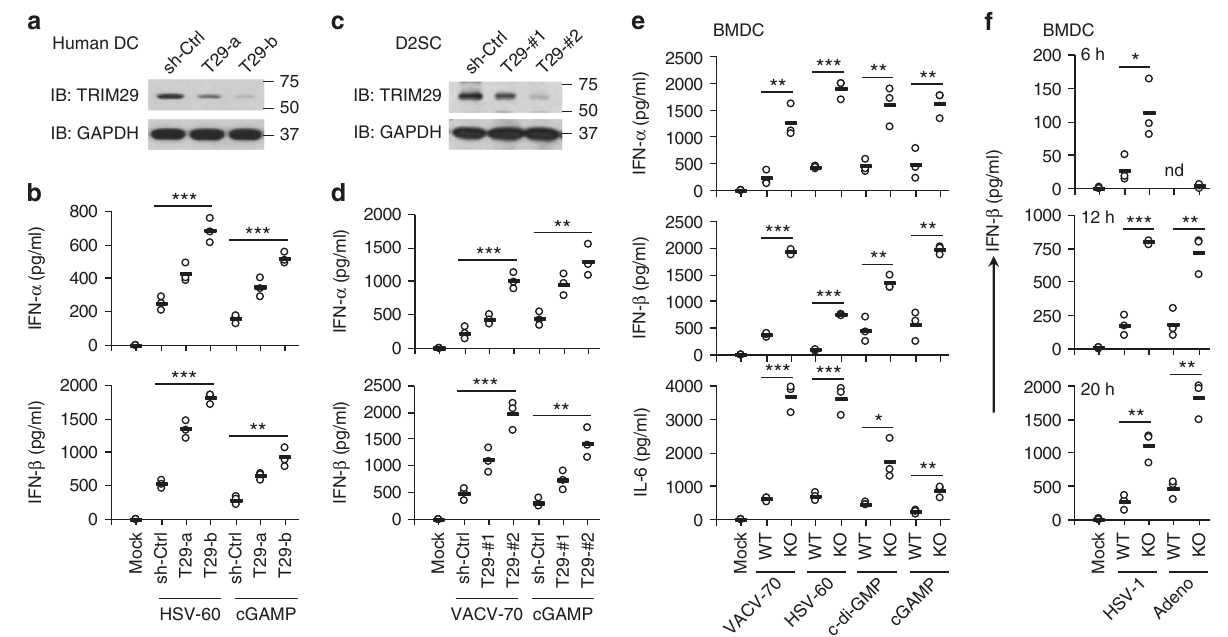
Fig. 3 TRIM29 plays an important role in regulating IFN-I production in dendritic cells. a Immunoblot analysis of TRIM29 in human monocyte-derived dendritic cells (MonoDC) treated with control shRNA with scrambled sequence (sh-Ctrl), shRNA targeting mRNA encoding TRIM29 (two shRNAs: T29-a and T29-b). GAPDH serves as a loading control throughout. b ELISA of IFN- α and IFN- β in MonoDCs treated with scrambled shRNA (sh-Ctrl) and left unstimulated (Mock) or treated with shRNA as above and then stimulated for 16 h with dsDNA derived from herpes simplex virus type 1 (HSV-60, 2.5 μ g/ml) or cGAMP (1.0 μ g/ml) delivered by Lipofectamine 3000. c Immunoblot analysis of TRIM29 in mouse D2SC cells treated with control shRNA with scrambled sequence (sh-Ctrl), shRNA targeting mRNA encoding TRIM29 (two shRNAs: T29-#1 and T29-#2). GAPDH serves as a loading control throughout. d ELISA of IFN- α and IFN- β in D2SC cells treated with scrambled shRNA (sh-Ctrl) and left unstimulated (Mock) or treated with shRNA as above and then stimulated for 16 h with dsDNA from vaccinia virus (VACV-70, 2.5 μ g/ml) or cGAMP (1.0 μ g/ml) delivered by Lipofectamine 3000. e ELISA of IFN- α , IFN- β , and IL-6 in BMDCs from WT and Trim29 -KO mice after 16 h of stimulation with dsDNA from vaccinia virus (VACV-70, 2.5 μ g/ml), dsDNA from HSV-1 virus (HSV-60, 2.5 μ g/ml), c-di-GMP (2.5 μ g/ml), or cGAMP (1.0 μ g/ml) delivered by Lipofectamine 3000. f ELISA of IFN- β in BMDCs from WT and Trim29 -KO mice mock infected or infected with HSV-1 or adenovirus (adeno) at multiplicity of infection (MOI) of 5 for 6, 12, or 20. Each symbol represents the value from independent experimental cells in each well; small horizontal lines indicate the average of triplicates. Mock, cells without stimulation or infection. * P < 0.05, ** P < 0.01, and *** P < 0.001 (unpaired t -test). The “ nd ” is de fi ned as not detectable. The position of protein markers (shown in kDa) is indicated on the right . Data are representative of three independent